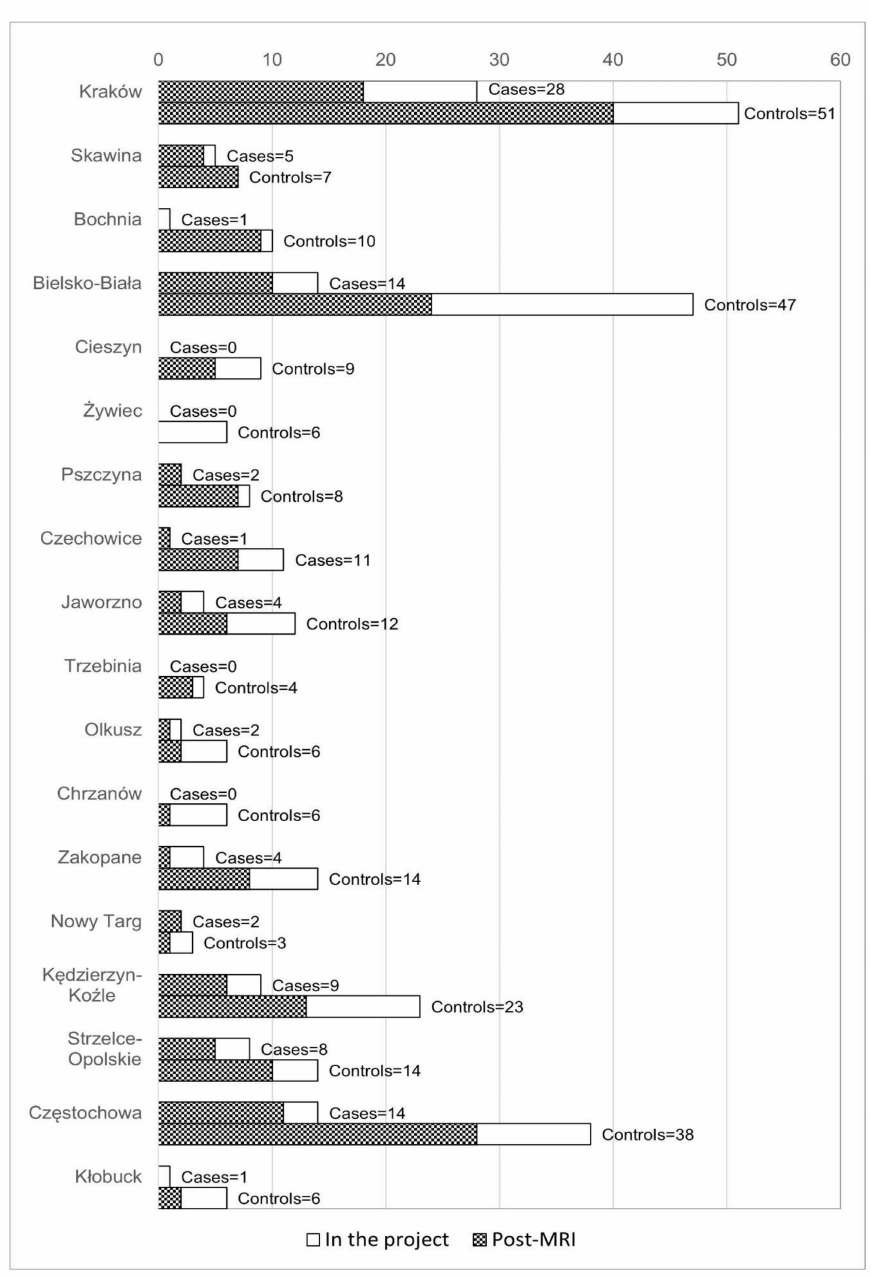
Figure 3. Town-level control-case-specific progress of testing children in the project as of 9 Septem- ber